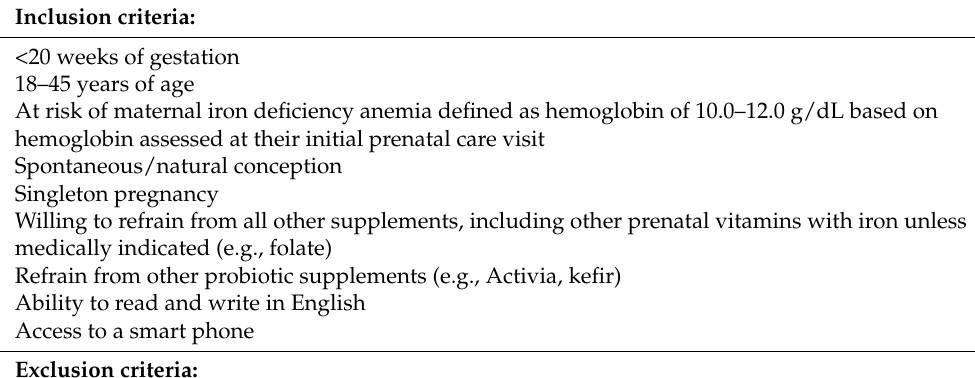
Table 1. Inclusion and exclusion